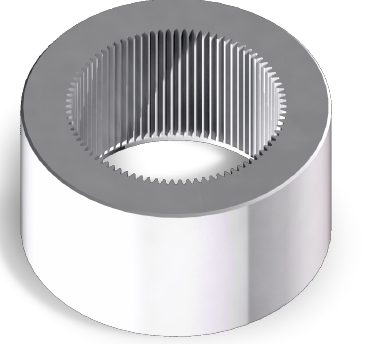
Figure 3. Overview and geometrical features of the